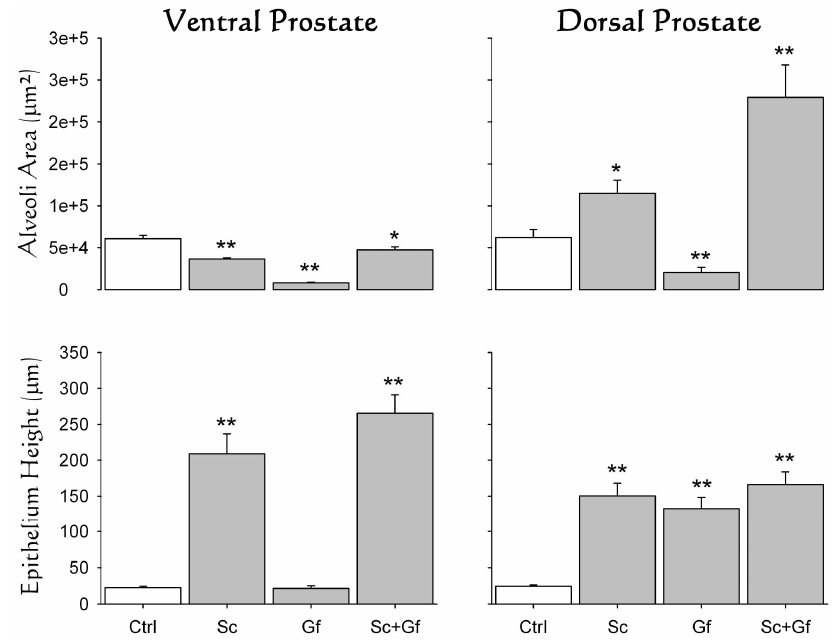
Fig. 3 – Graphic representation of histological changes. Modification of prostate tissue parameters following denervation of scrotal (Sc) and genitofemoral (Gf) nerves alone or combined (Sc+Gf). Data showed individual effects of ventral and dorsal regions of the prostate. Gray bars are compared against the white bar representing the control value (Ctrl). * = p < 0 . 05; ** = p < 0 .